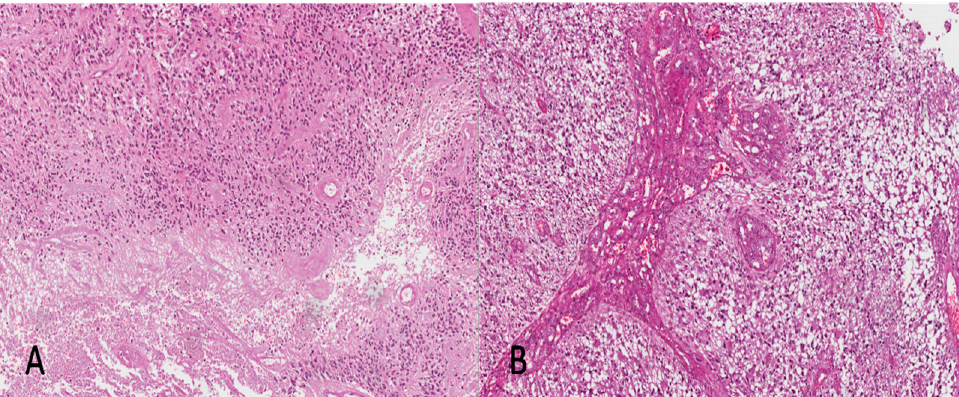
Figure 1. Histopathology of EC. All surgical samples from the ECs exhibited the conventional morphological features of GBM, IDHwt, consisting of hypercellular astrocytic neoplasms with necrosis ( A ) and/or MVP ( B ) (( A , B ) H&E; original magnifications 100×).